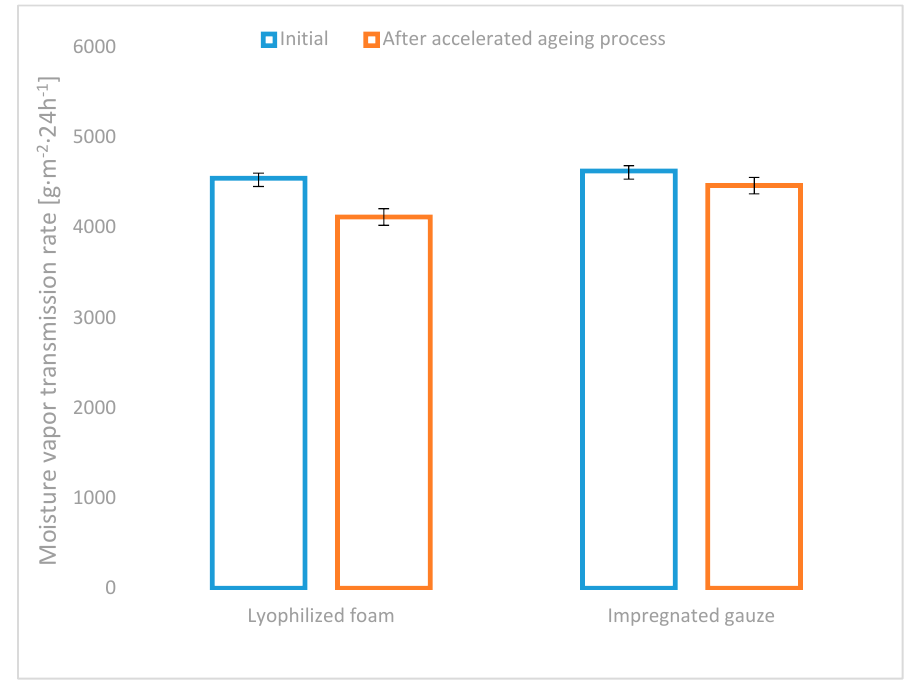
Figure 5. Absorption under free soaking of the studied usable forms of the haemostatic agents before and after accelerated ageing.